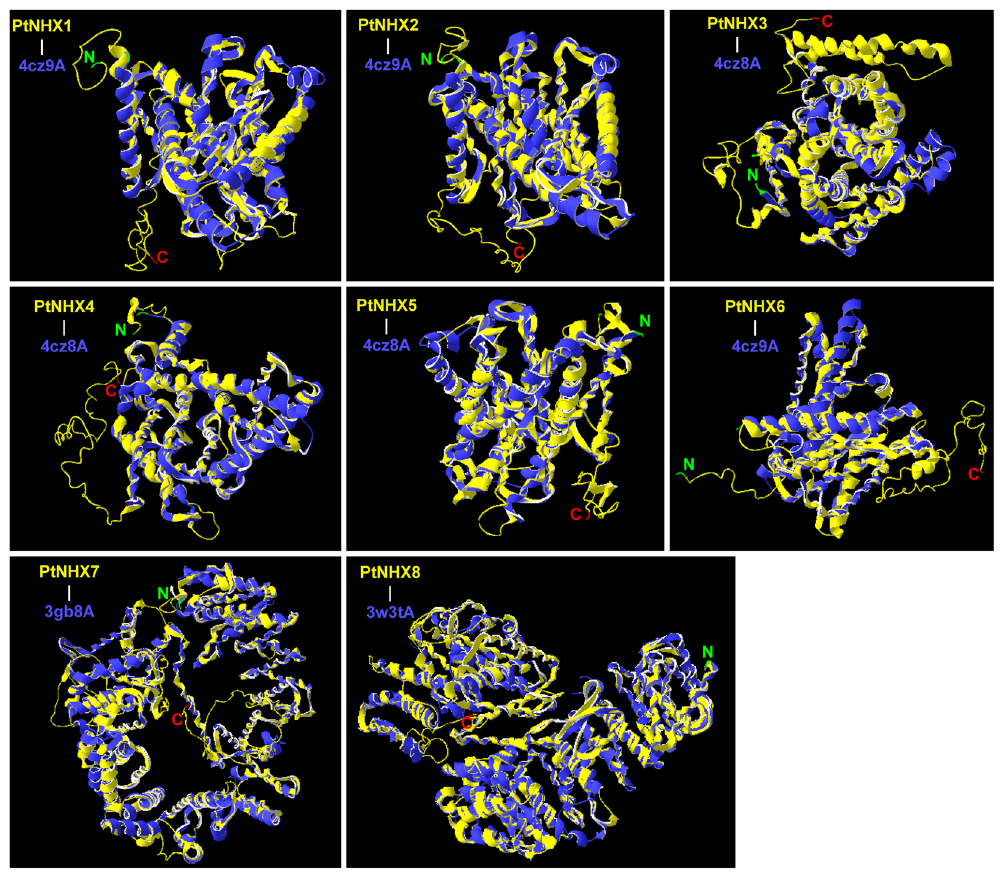
Figure 4. Structural analysis of PtNHX proteins. Yellow chains indicate the PtNHX proteins and blue chains indicate the best identified structural analogs in PDB for each PtNHX protein (Table 3). Details of secondary structure of PtNHX proteins are shown in Fig.